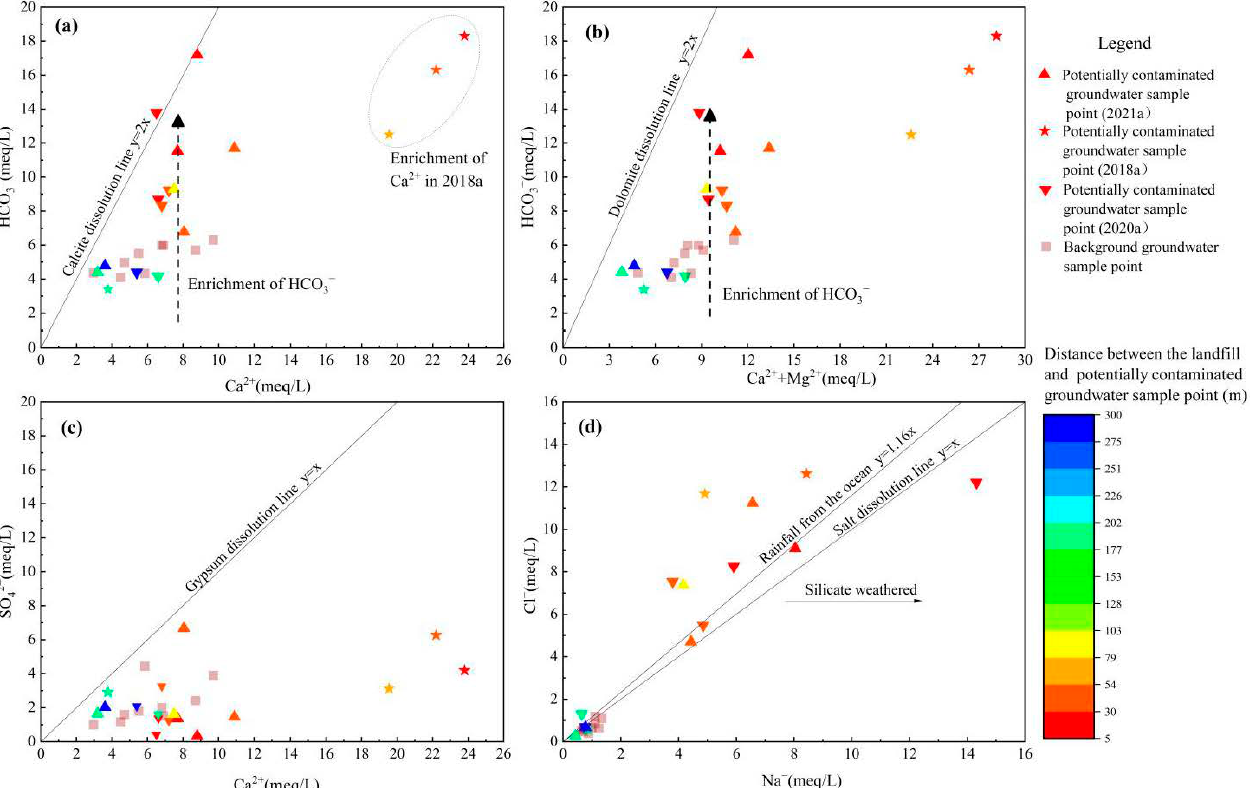
Figure 3. ( a ) γ (HCO 3 − )/ γ (Ca 2+ ) in the groundwater of the study area; ( b ) γ (HCO 3 − )/ γ (Ca 2+ +Mg 2+ ) in the groundwater Figure 3. (a) γ (HCO 3 − )/ γ (Ca 2+ ) in the groundwater of the study area; (b) γ (HCO 3 − )/ γ (Ca 2+ +Mg 2+ ) in the groundwater of of the study area; ( c ) γ (SO 42 − )/ γ (Ca 2+ ) in the groundwater of the study area; ( d ) γ (Cl − )/ γ (Na + ) in the groundwater of the study area; (c) γ (SO 42 − )/ γ (Ca 2+ ) in the groundwater of the study area; (d) γ (Cl − )/ γ (Na + ) in the groundwater of the study area. the study